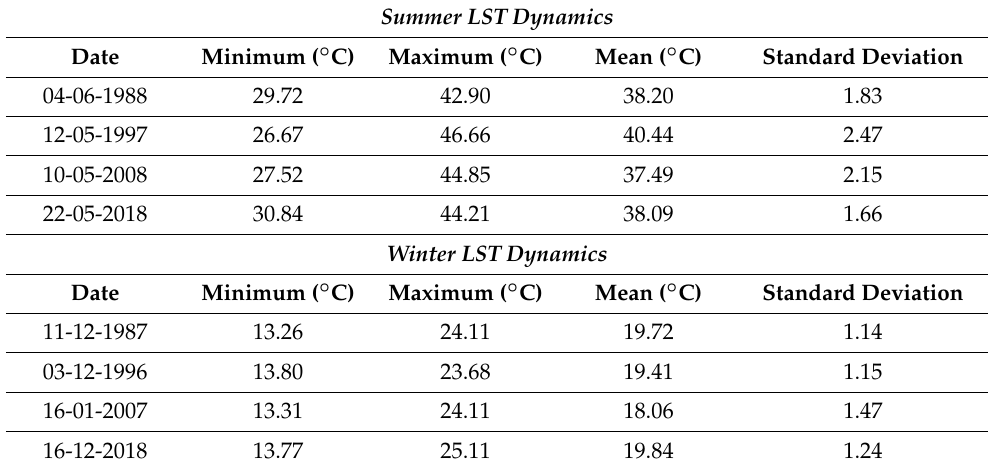
Table 4. Summer/winter seasonal LST dynamics of Prayagraj city